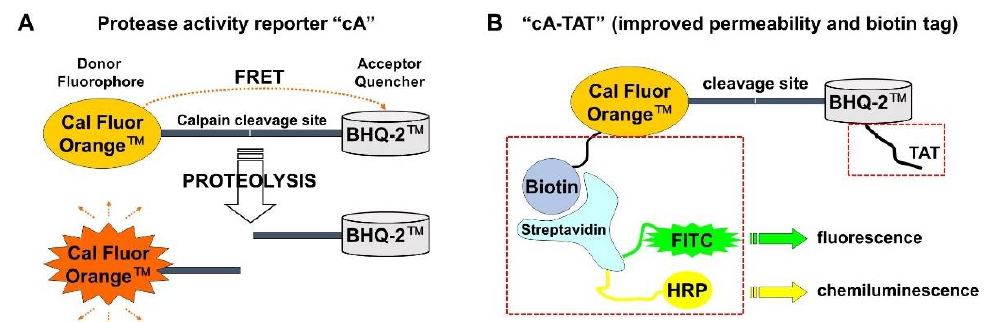
Figure 1. Schematics illustrating the design of the internally quenched small-molecule protease reporters used in this study. The diagram in ( A ) shows reporter cA, which consists of an N-terminal fluorophore, Cal Fluor Orange, and a C-terminal quencher, BHQ-2, separated by a peptide consisting of a calpain cleavage site within murine vimentin (GSG|TSS). The diagram in ( B ) shows the next- generation reporter cA-TAT, which includes the modifications highlighted by dashed boxes: an N-terminal biotin conjugation to cA and a C-terminal TAT peptide sequence (GRKKRRQRRRPQ). The biotin moiety enables detection of the intact molecule and the N-terminal cleavage product by streptavidin conjugated to either horseradish peroxidase (HRP) or a fluorescent label, such as fluorescein isothiocyanate (FITC), while the TAT peptide confers enhanced cell permeability. Neurons in eight-well Lab-Tek chambers were pre-treated with calpain inhibitor (MDL28170 or E64d, each at 20 µ M), proteasome inhibitor MG132 (20 µ M), or dimethyl sulfoxide (DMSO) vehicle control for 10–30 min, as indicated in figure legends, and then cA or cA-TAT was loaded for 80 min prior to image acquisition. In cA-TAT